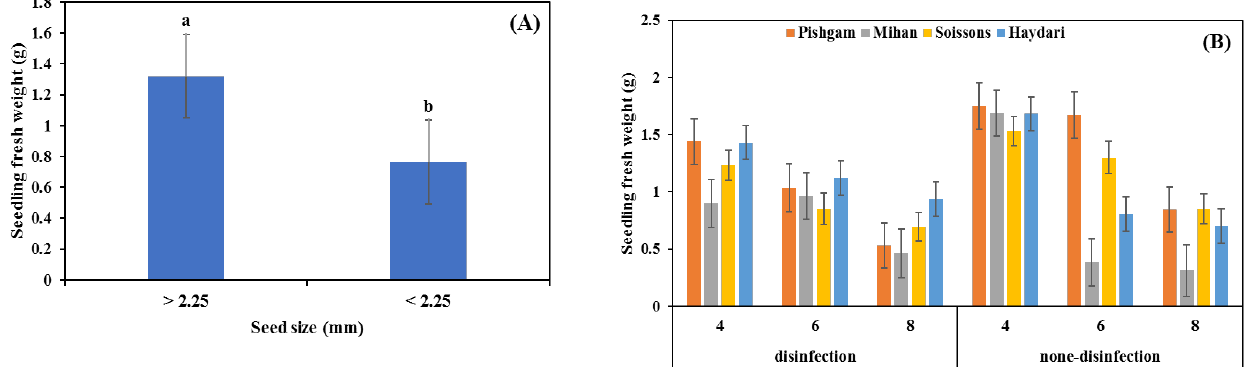
Figure 6. Effect of seed size ( A ), disinfection, cultivars, and depth sowing ( B ) on seedling fresh weight. The columns’ letters indicate the differences between the different treatments ( p < 0.05) using the LSD test.